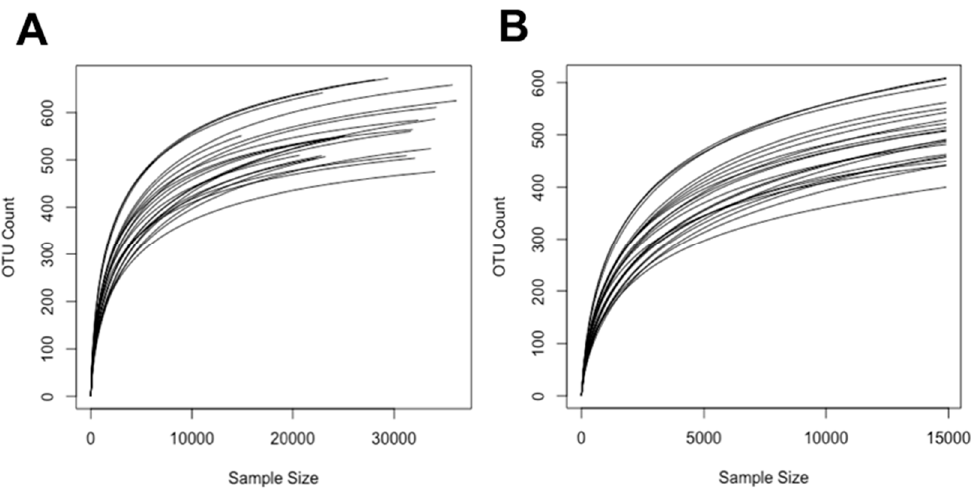
Figure 6. Rarefaction curves ( A ) before and ( B ) after normalisation (14,908 sequences).